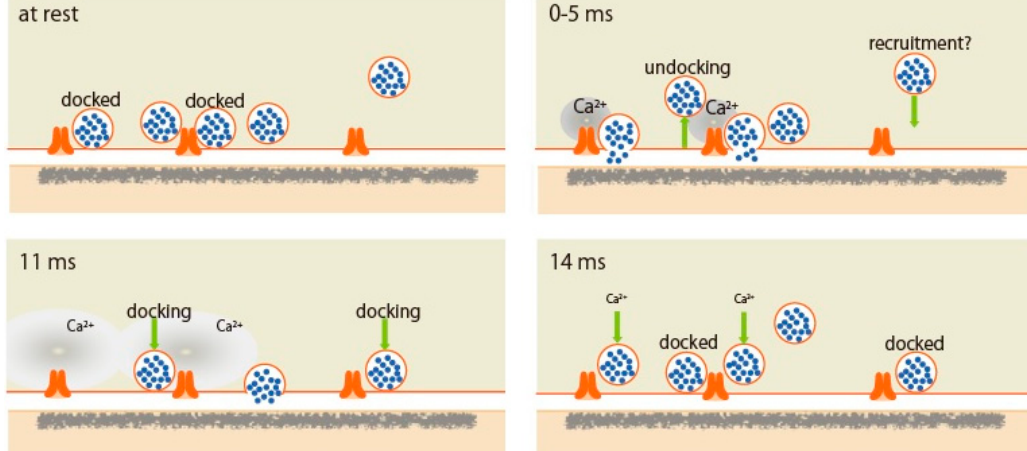
Figure 1. Scheme of synaptic vesicle dynamics in the active zone demonstrated by the ‘zap-and-freeze’ method. (At rest) Synaptic vesicles (SVs) beneath the active zone (AZ) are transit between docked and undocked states. Docked SVs are ready to fuse in response to action potential (AP). (0–5 ms) Synchronous SV fusion, often of multiple SVs, starts within hundreds of microseconds of an AP. Fused SVs collapse into the plasma membrane by 11 ms. (11 ms) From 5 to 11 ms, SV fusion, toward the center of the AZ, is asynchronized. SVs start to be recruited. (14 ms) SVs are docked to fully replace the used SV for fusion. These docked SVs reduces within 100 ms. Reproduced from Kusick et al., 2020 [10].